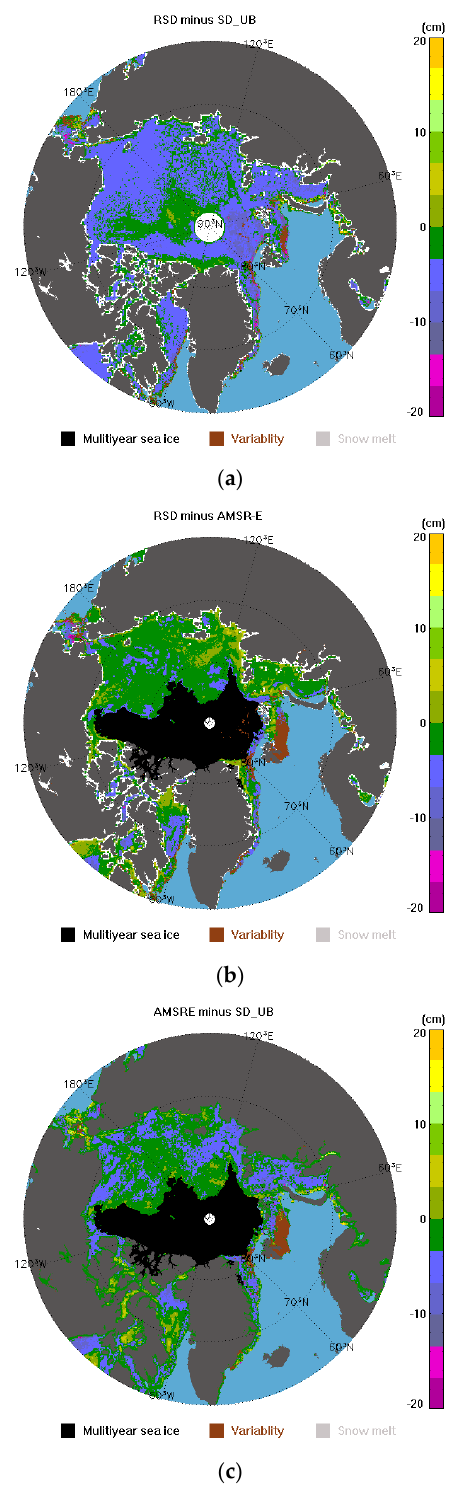
Figure 16. Differences in snow depths among the three datasets on 1 March 2011. ( a ) RSD